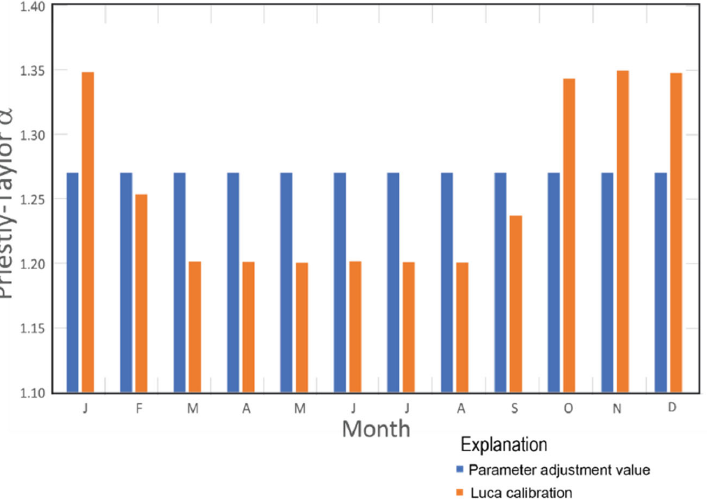
Figure 12. Evapotranspiration parameter α ( pt_alpha ) before and after Luca calibration step 2.